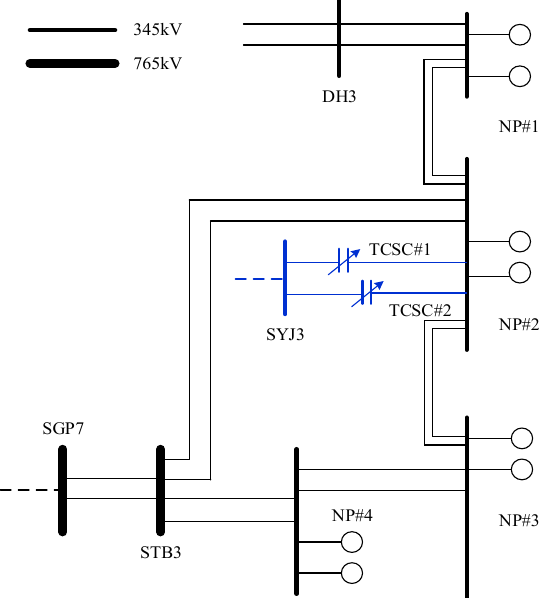
Figure 1. Simplified East Coast power grid configuration.